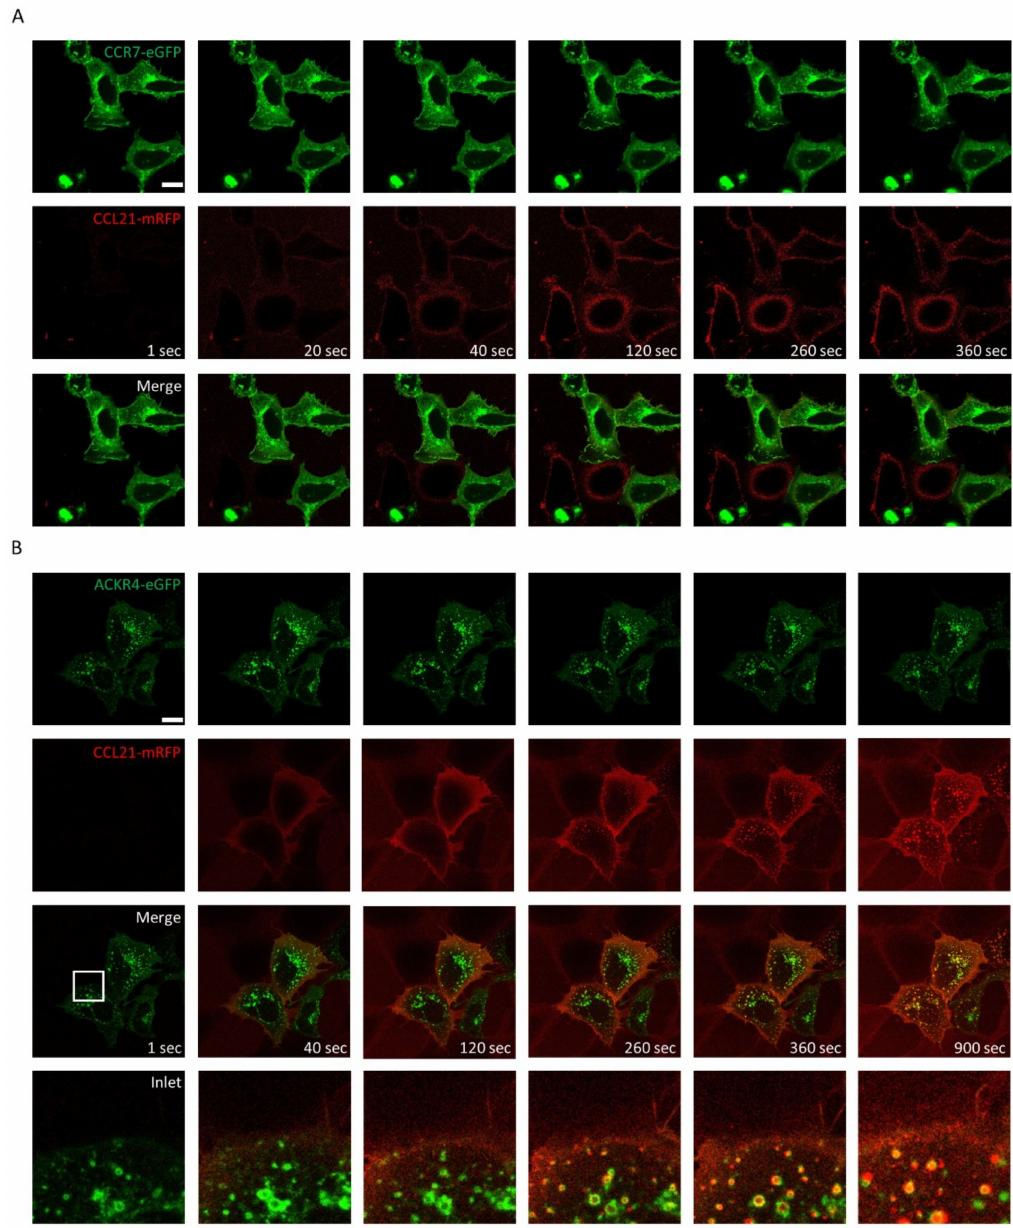
Figure 4. Monitoring CCL21-mRFP binding to CCR7-eGFP and internalization by ACKR4-eGFP. 100nM of CCL21-mRFP was added to HEK293 cells transiently transfected with CCR7-eGFP ( A ) or ACKR4-eGFP ( B ) and CCL21-mRFP binding and receptor trafficking was recorded by time-lapse video microscopy. Series of images captured at indicated time points are depicted (scale bar: 10 µ m). White frames: magnification of